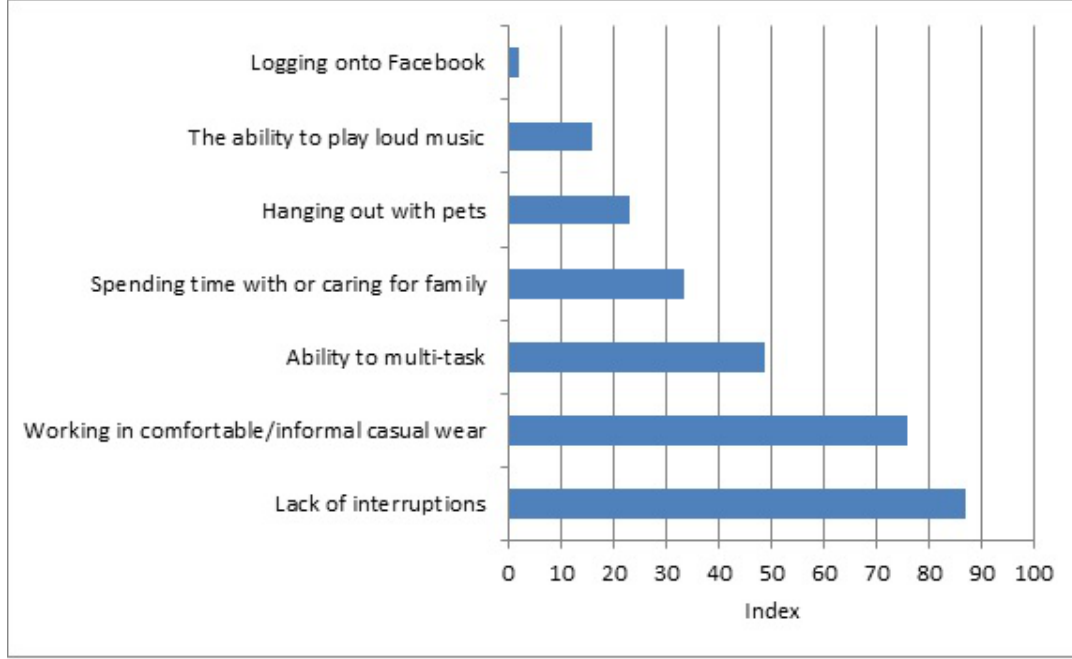
Figure 2. Enjoyment rankings of academic